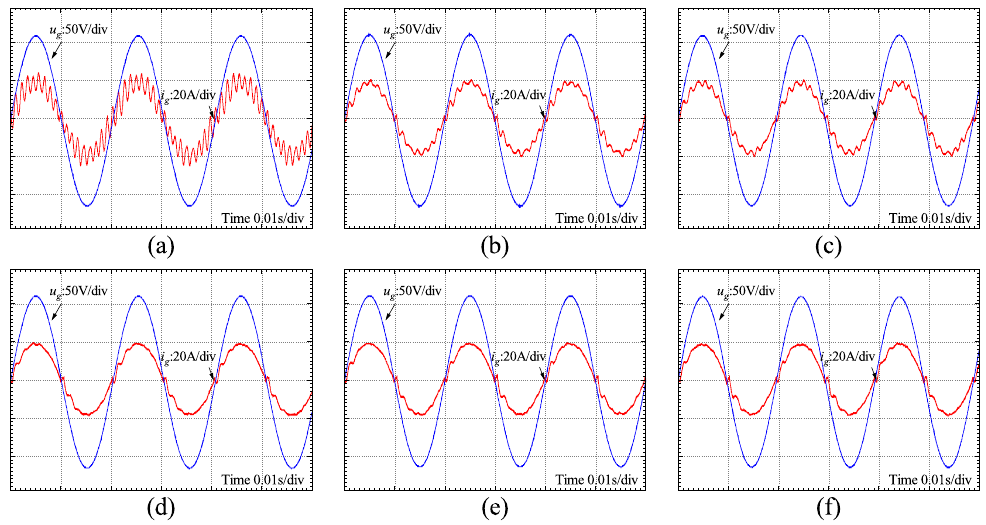
Figure 19. The waveform of grid voltage u g and grid current i g when L 1 e varies to 2.6 mH. ( a – c ): using FIR filters when the grid frequency is 49 Hz, 50 Hz, and 51 Hz. ( d – f ): using IIR filters when the grid frequency is 49 Hz, 50 Hz, and 51 Hz.